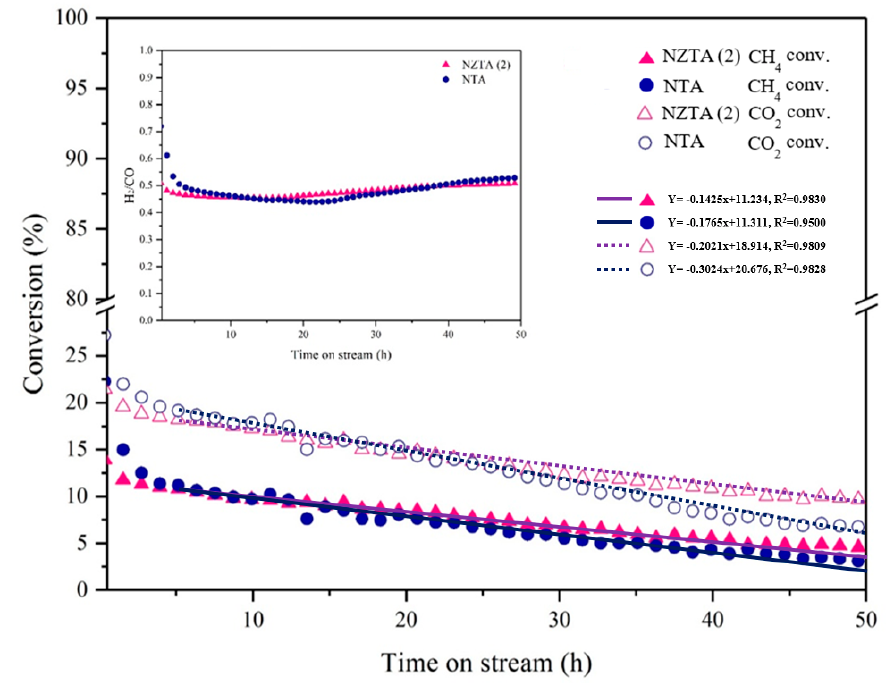
Figure 10. Catalytic stability of the prepared catalysts (NZTA (2) and NTA) reacted for 50 h. It is considered that NTZA (2) has better stability than NTA by about 19%. Additionally, NZTA (2) catalyst explicitly exhibited higher coke resistance based on the TGA results shown in Figure 11.